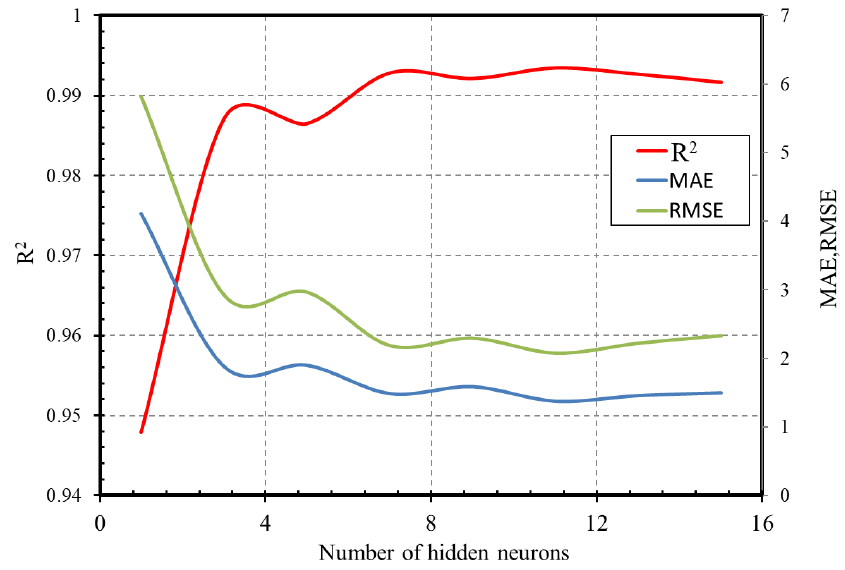
Figure 14. Performance evaluation of horseshoe tunnel models against the number of hidden neurons with two layers.